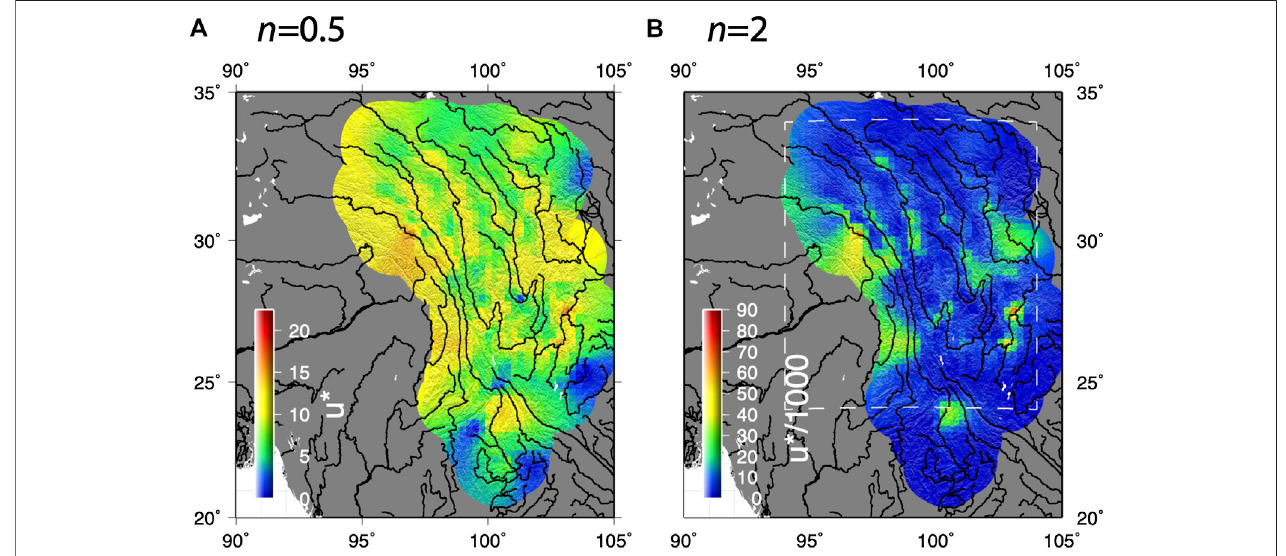
FIGURE9| Nonlinearitiesinthestreampowermodel. (A) Normalizedchannelsteepnessvaluesfor n (cid:1) 0.5.Overallmagnitudesarereducedandthereislessspatial variability in the u* map; (B) If n (cid:1) 2, more spatial variability is predicted, and magnitudes increase. The box shows the regional extent of the map in Figure 10 .